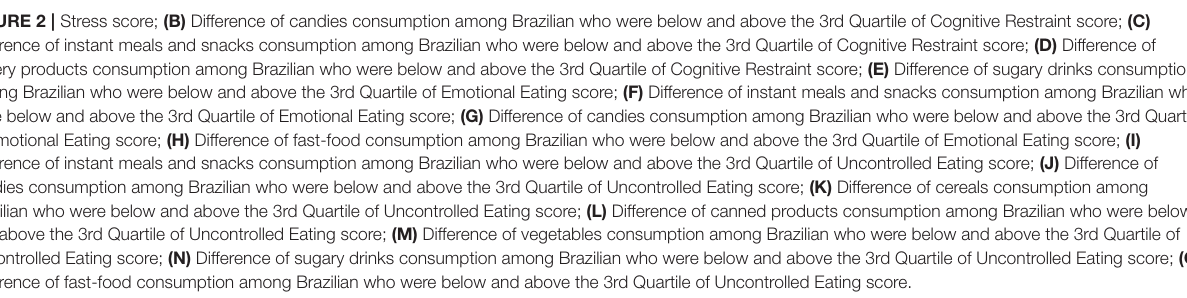
TABLE 2 | Factors independently associated with the last quartile of the eating behaviors and stress among Brazilians during the pandemic period in multivariate